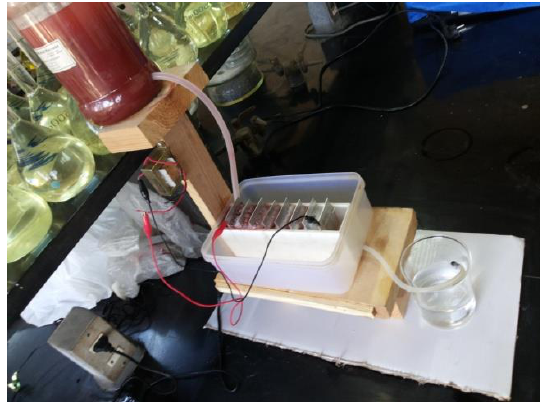
Figure 4. Photo of the designed Electro-Flotation